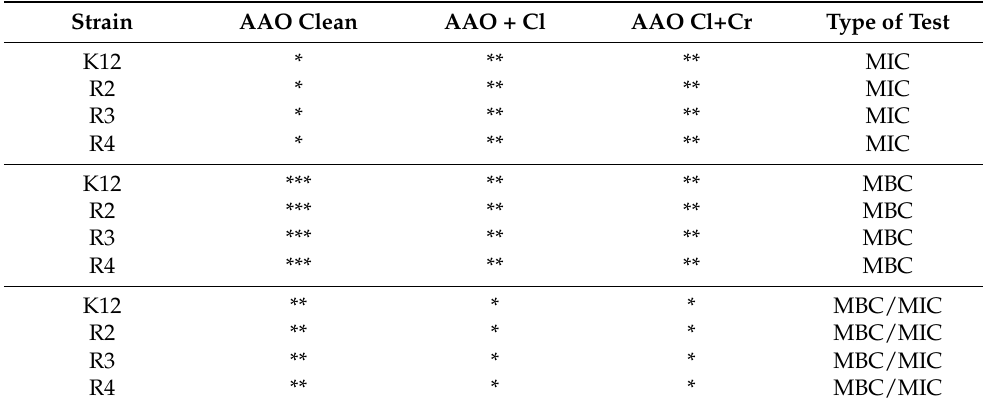
Table 1. The statistical analysis of the measured membranes by MIC, MBC and MBC/MIC; <0.05 *, <0.01 **, <0.001